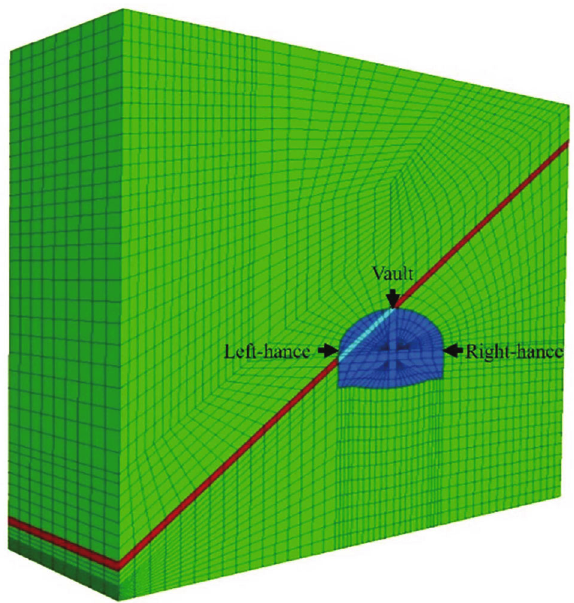
Figure 3: Grid diagram of numerical